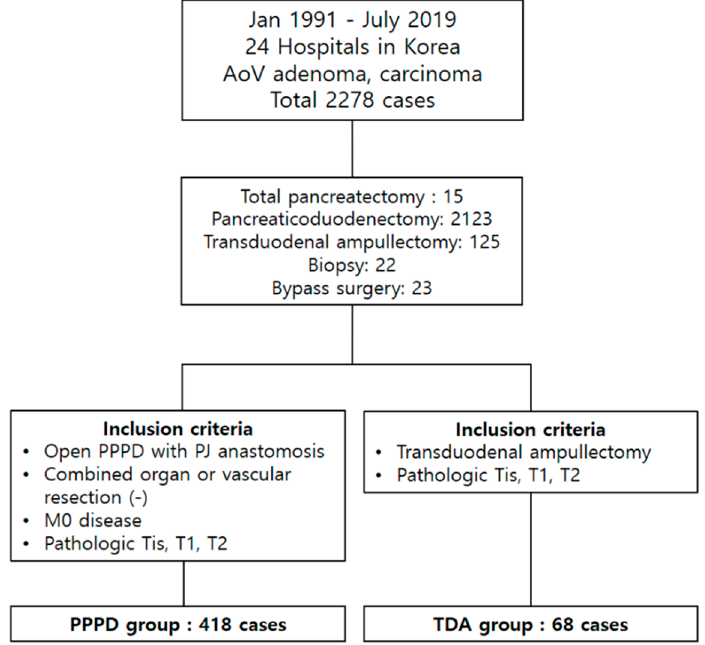
Figure 1. Patient allocation between the PPPD and TDA groups.